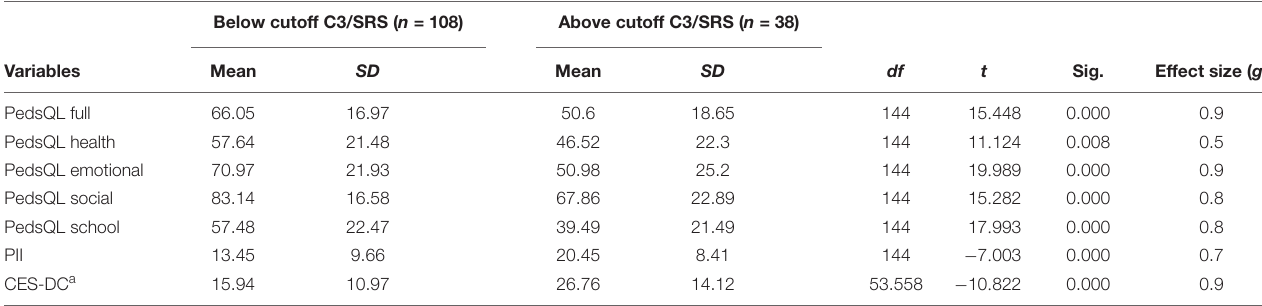
TABLE 2 | Independent groups t -tests between variables related to pain interference (PII), depression (CES-DC), and HRQoL (PedsQL) and cutoff status for clinically significant traits and symptoms of either autism (SRS) or ADHD (C3) ( n = 146). Below cutoff C3/SRS ( n = 108) Above cutoff C3/SRS ( n = 38)